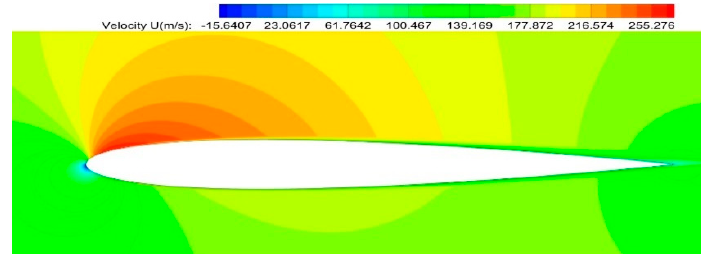
Figure 13. 4° angle of attack, speed distribution of standard NACA0012 airfoil.